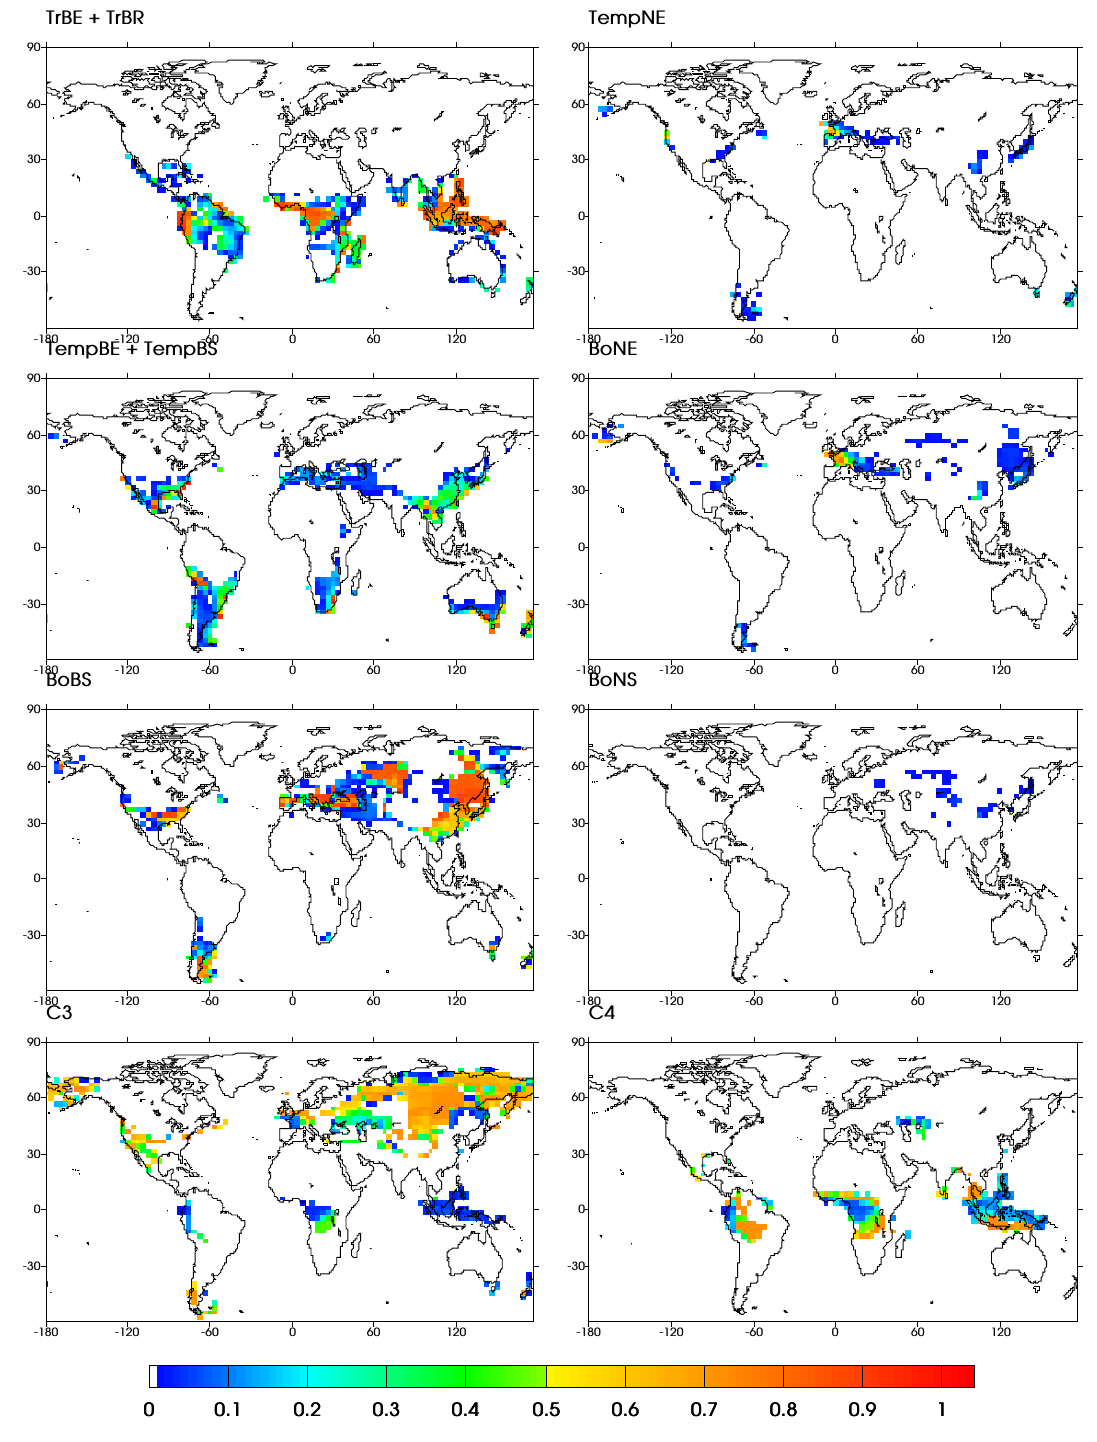
Fig. 7. Fraction of vegetation (annual maximum, in % of grid-cell) simulated by ORCHIDEE in LGMG (LGM climate and LGM CO 2 ). Abbreviations: see Table